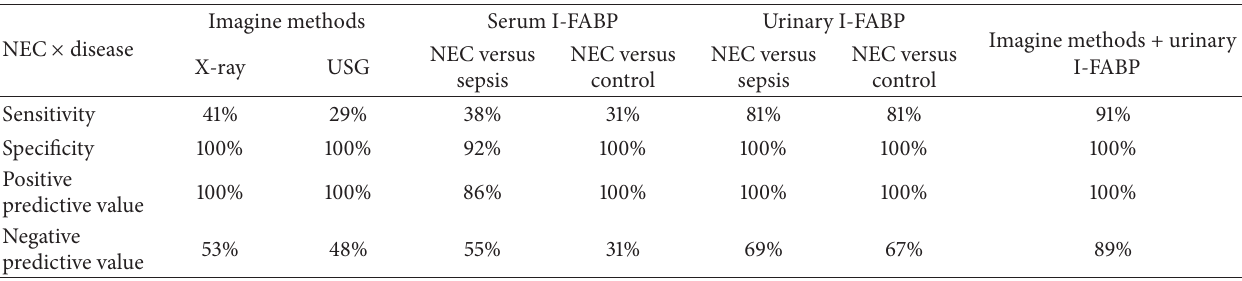
Table 2: Diagnostic performance of standard X-ray (gold standard), ultrasound, and serum or urinary I-FABP as analyzed in this study. Imagine methods refer collectively to the X-ray and ultrasound